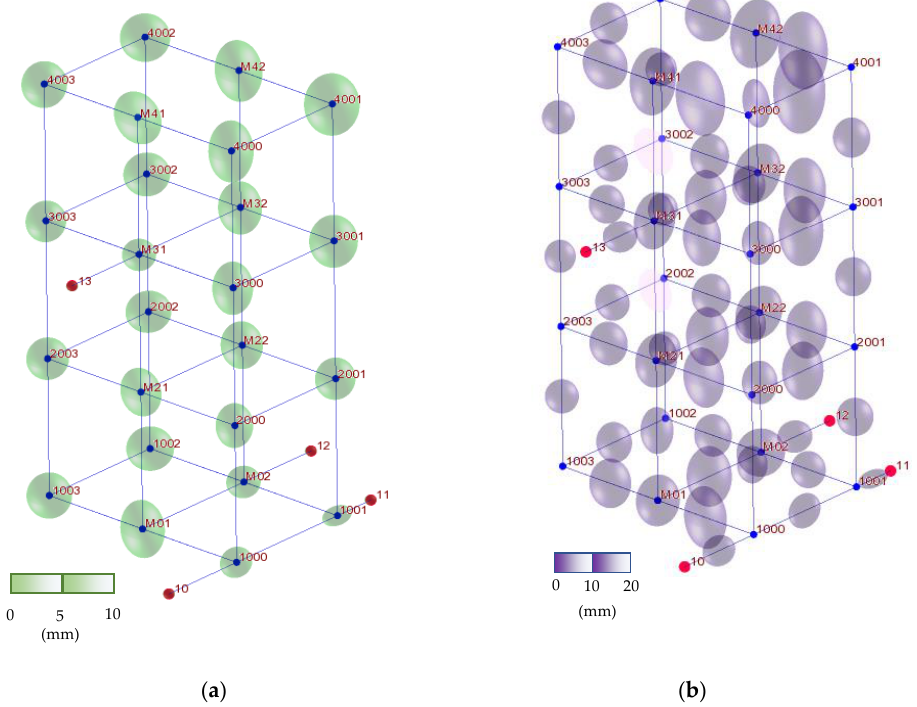
Figure 23. The error ellipses of coordinate determination: ( a ) the accuracy ellipses of the point coordinate determination; ( b ) the relative accuracy ellipses of the point coordinates.